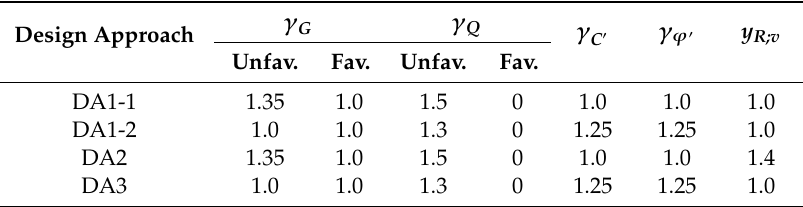
Table 2. Partial factors for GEO ultimate limit